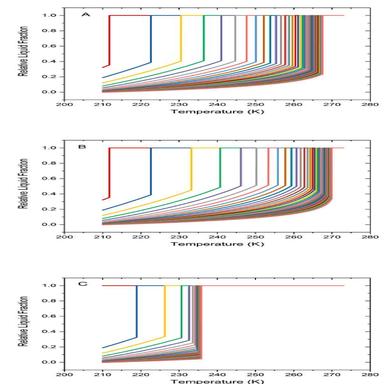
Transition kernels (A) for equilibrium transition θeq(T, x), (B) for metastable melting θml(T,x), and (C) homogeneous ice nucleation θhn(T,x). The range of the pore sizes shown is from 2 nm to 20 nm in steps of 0.5 nm (from left to tight).